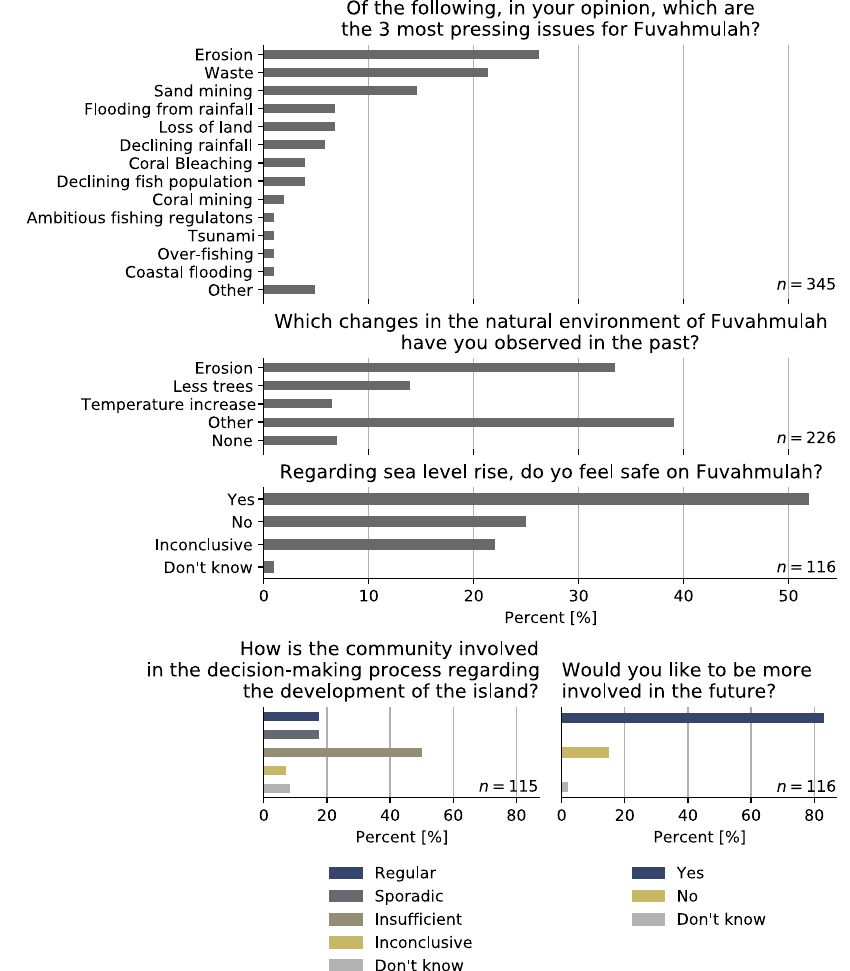
Fig. 8 Results from the population survey. Selected questions and answer frequency from the population survey. See Supplementary Information File for the question type (open or closed question) as well as associated codes and coding